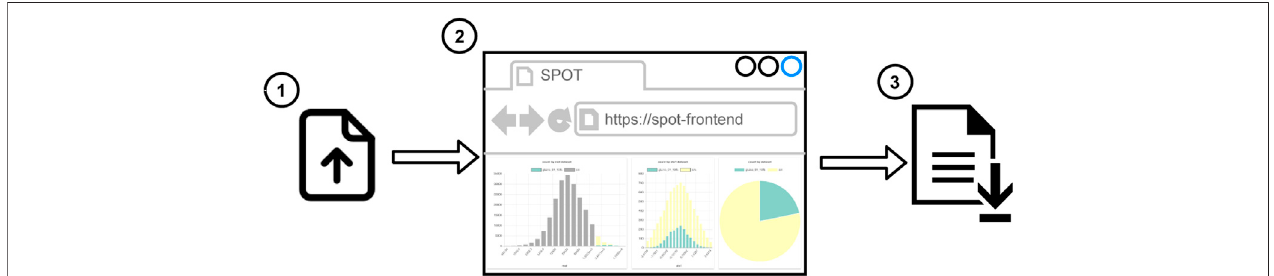
FIGURE 2 | Work fl ow to use SPOT in client mode.